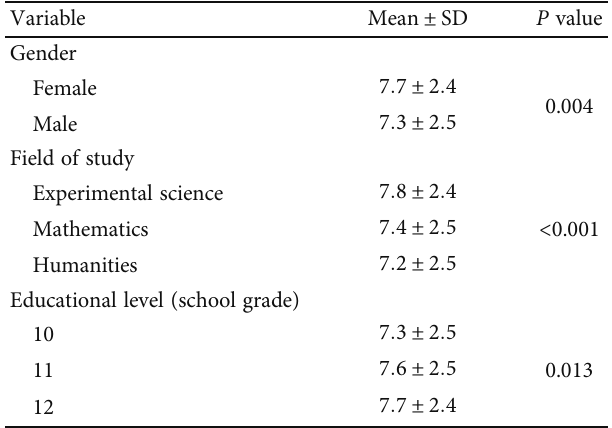
Table 4: The relationship between depression health literacy score with gender, the fi eld of study, and educational level.